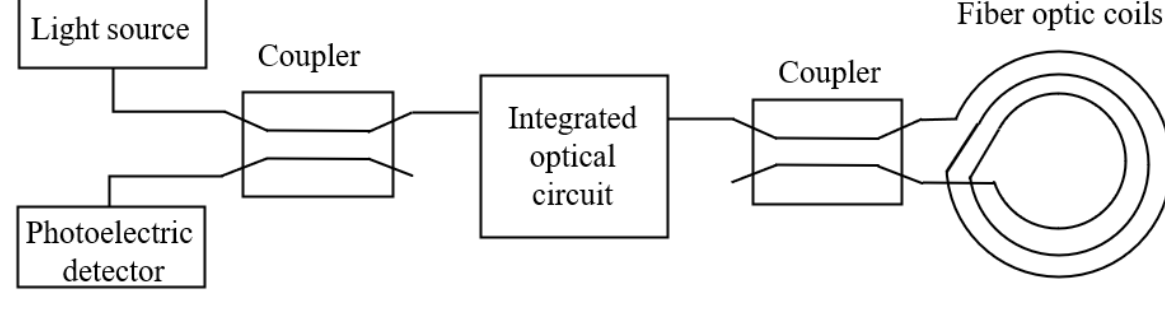
Figure 7. Physical model of FOG.